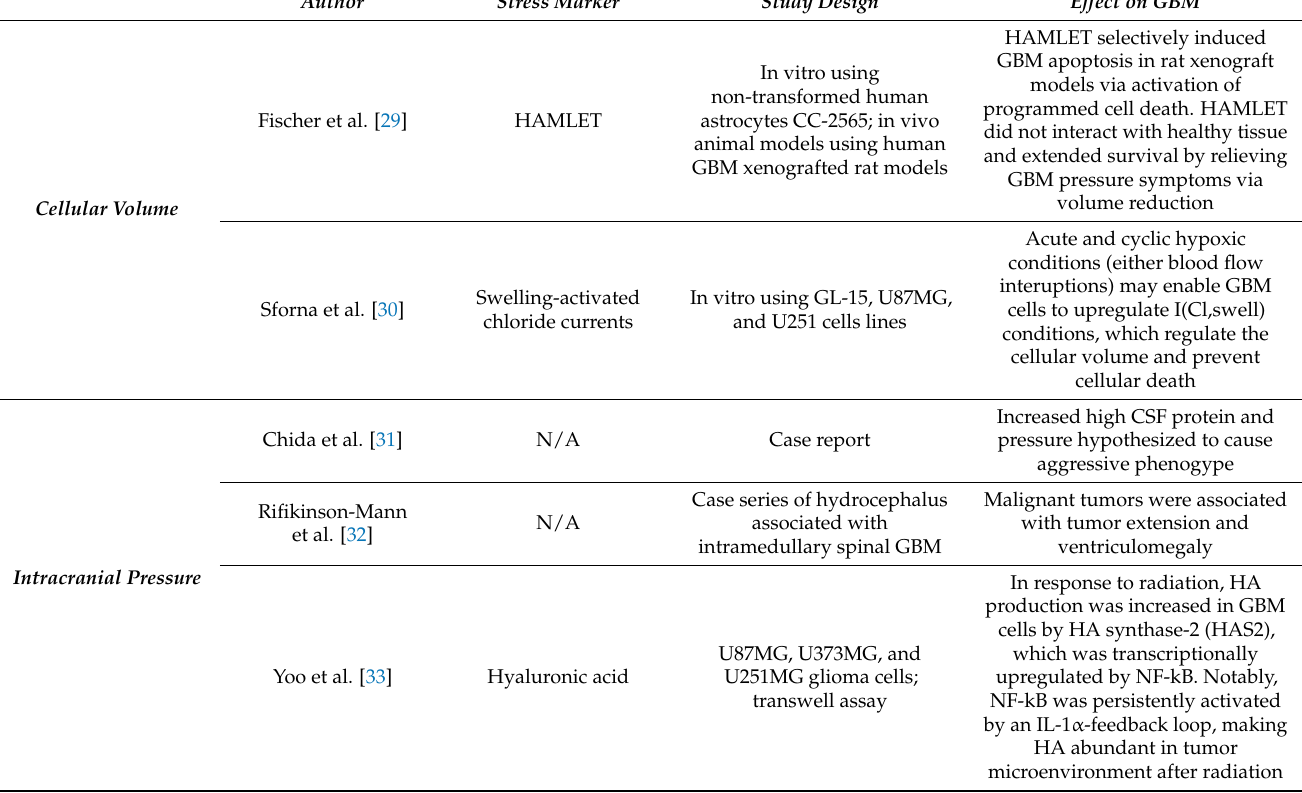
Table 2. Tumor Microenvironment Forces in